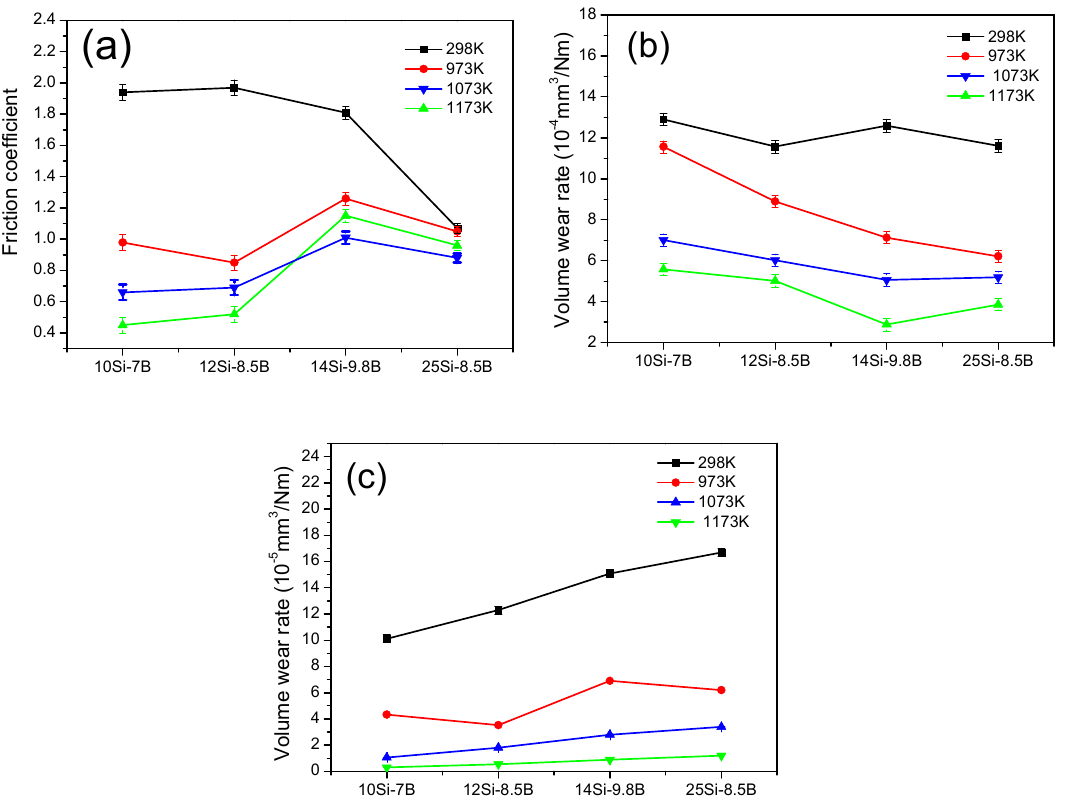
Figure 5. ( a ) Friction coefficients and ( b ) volume wear rates of the plate specimens of Mo-Si-B alloy sliding against the Si 3 N 4 ball specimens ( c ) in the temperature range of 298 to 1173 K.